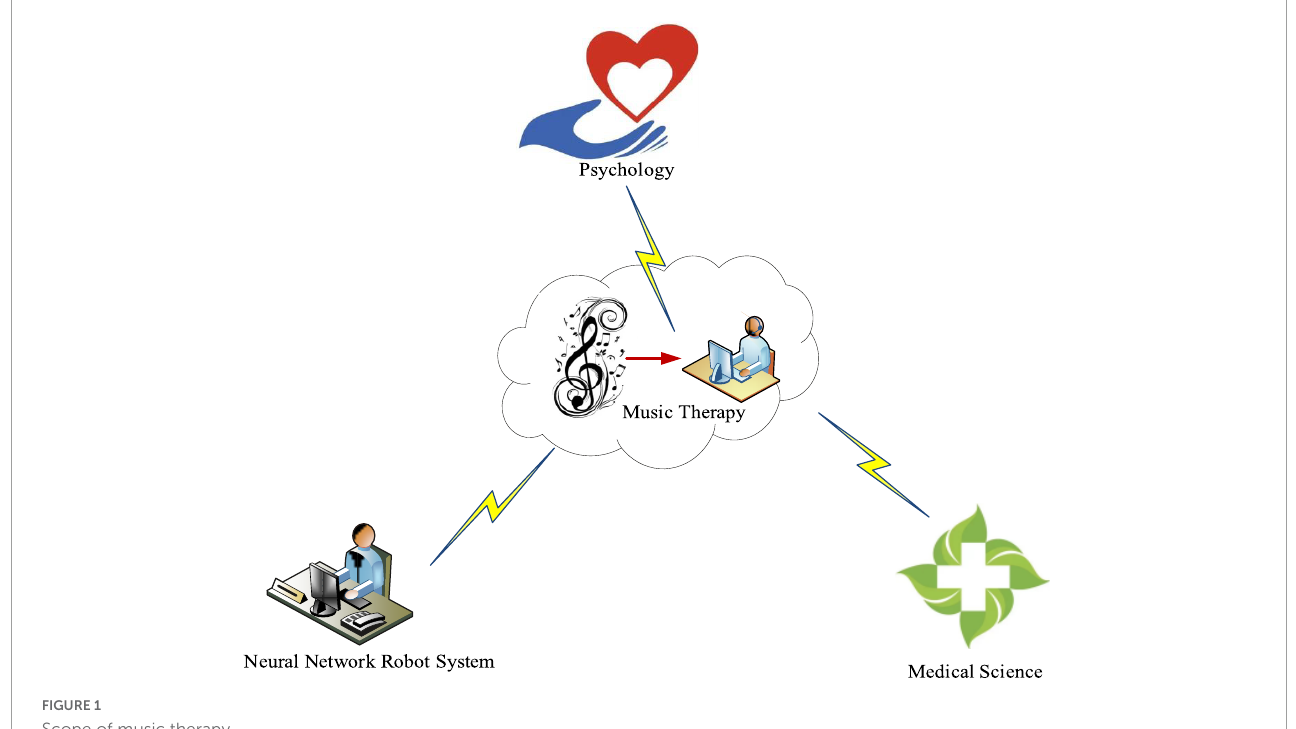
FIGURE1 Scope of music